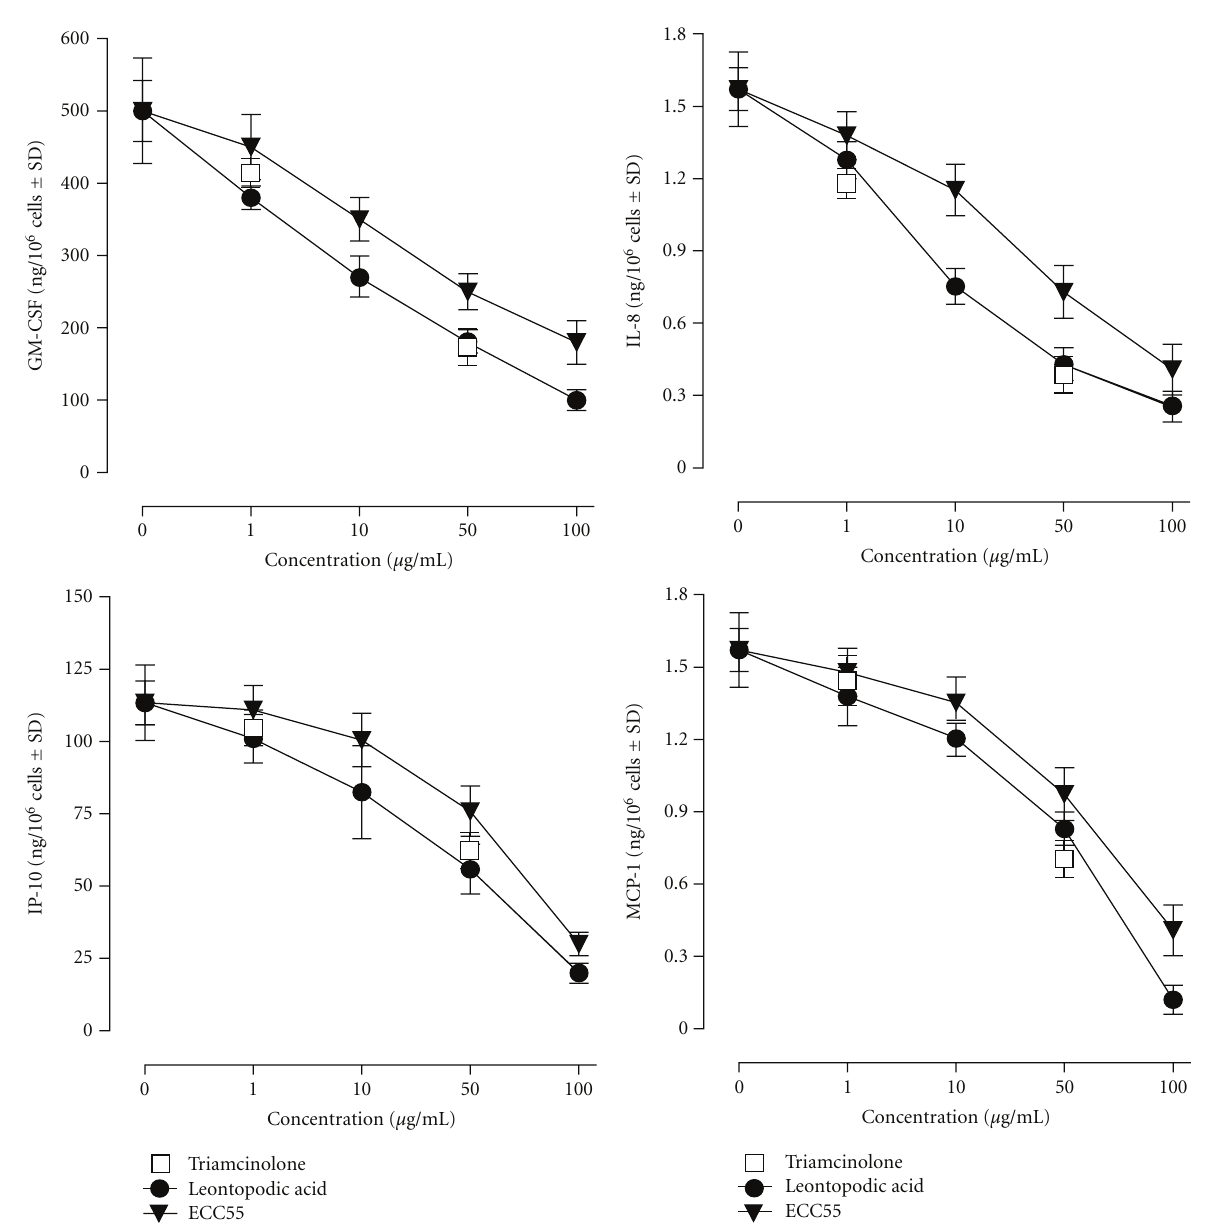
Figure 3: Dose-dependent e ff ects of ECC55 and leontopodic acid on the chemokine and growth factor released from cultured human keratinocytes treated with proinflammatory combination of TNF α and IFN γ (T/I). Concentrations (ng/10 6 cells) of granulocyte- macrophage colony-stimulating factor (GM-CSF), interleukin 8 (IL-8), interferon gamma-produced protein of 10kDa (IP-10), and monocyte chemotactic protein-1 (MCP-1) were determined in the cellular supernatant at 24 h after keratinocyte challenge with T/I known to stimulate maximal inflammatory response. Keratinocytes were pretreated for 30min with increasing concentrations ( μ g/mL) of either ECC55 or pure commercial leontopodic acid. The corticosteroid triamcinolone was used as a positive control for e ff ective inhibition of cytokine/chemokine release at the two concentrations indicated. Error bars in all figures correspond to S.D. Background release of IL-8 was 0 . 29 ± 0 . 04ng / 10 6 cells, IP-10 was 0 . 001 ± 0 . 000ng / 10 6 cells, GM-CSF was 0 . 07 ± 0 . 01ng / 10 6 cells, and MCP-1 was 0 . 018 ± 0 . 02ng / 10 6 cells. Spontaneous production of IP-10 and MCP-1 was not changed in the presence of either ECC55 or pure commercial LA, whereas basal GM-CSF and IL-8 levels were decreased by ECC55 and LA dose